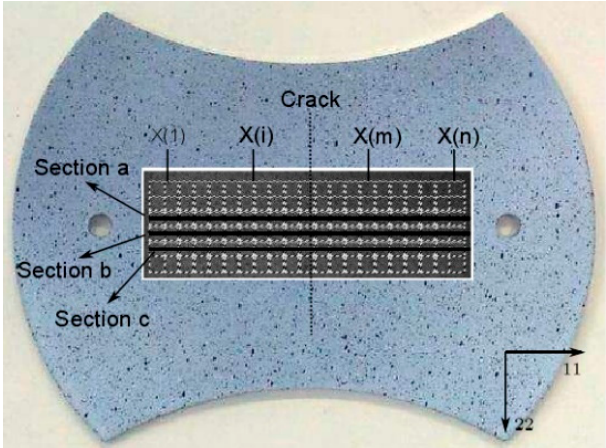
Figure 2. Locations of the three relevant cross sections.